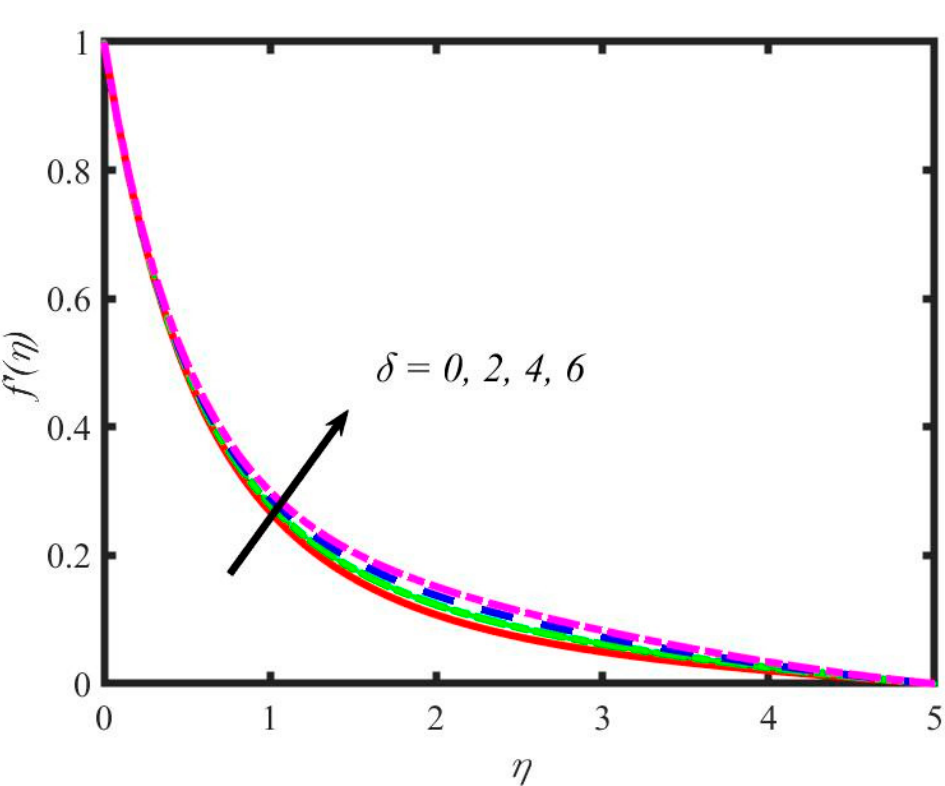
Figure 3. Variations in velocity for Lewis number.